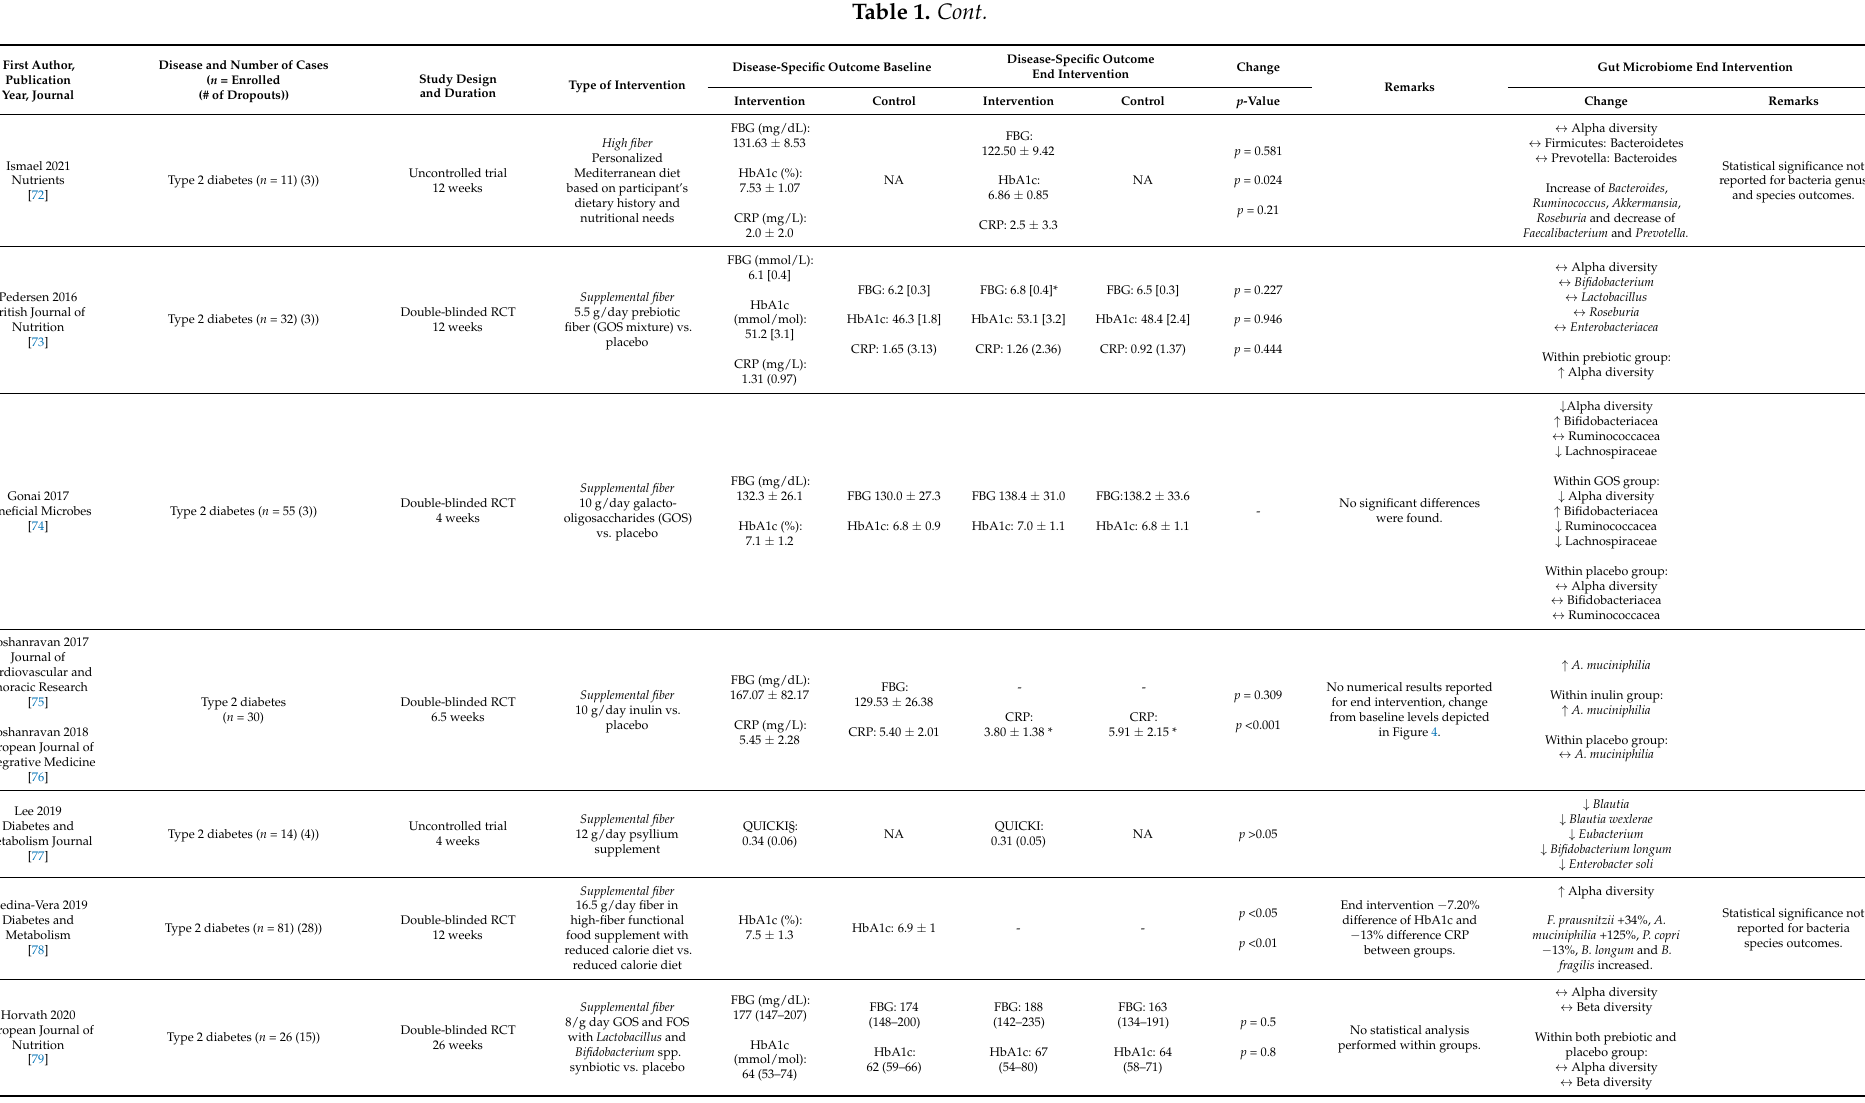
Nostatisticalanalysis performedwithingroups.